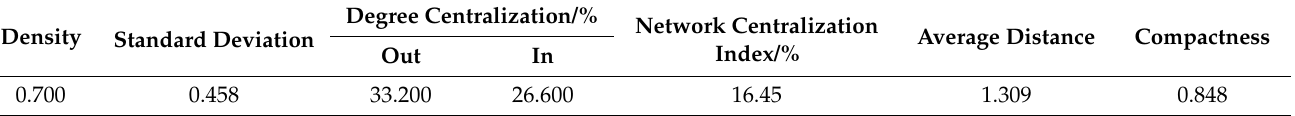
Table 5. Overall network